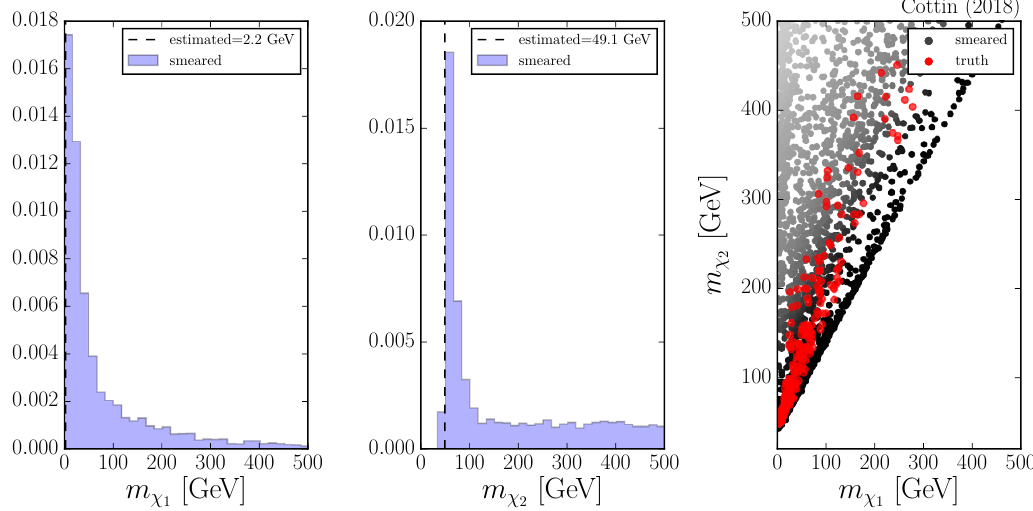
Figure 3 . Solutions for the masses including all detector e(cid:11)ects. The estimated mass values for the daughter (cid:31) (left) and parent (cid:31) (middle) are shown in the label. The right far plot shows the 1 2 truth solutions and the solutions after considering all detector e(cid:11)ects (or smearings). The truth values of the mass pair are ( m (cid:31) ) = (1 ; 50) GeV. ; m (cid:31) 1 2